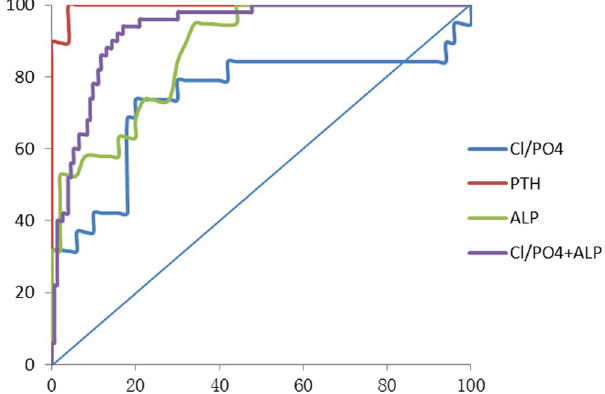
Figure 1. Receiver-operating characteristic curves used for predicting normocalcaemic PHPT (NPHPT) and comparison of the area under the receiver-operating characteristic curves (ROC-AUC). Note: Parathyroid hormone (PTH), ROC-AUC = 0.996 (95% confidence interval [CI], 0.000–1.000); chloride/phosphate ratio (Cl/PO 4 ), ROC-AUC = 0.743 (95%CI, 0.587–0.899); alkaline phosphatase (ALP), ROC-AUC = 0.875 (95% CI, 0.792–0.958), Cl/PO 4 + ALP, ROC-AUC = 0.913 (95%CI, 0.744–1.000) between normocalcaemic PHPT (NPHPT) and normal